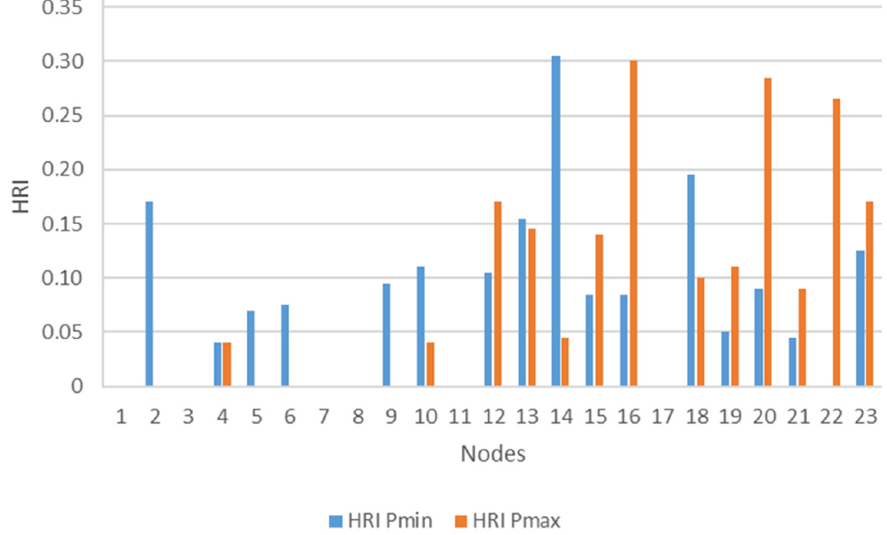
Water 2019 , 11 , x FOR PEER REVIEW Figure 8. Hydrant risk indicator (HRI) for 50 configurations. Figure 8. Hydrant risk indicator (HRI) for 50 configurations.